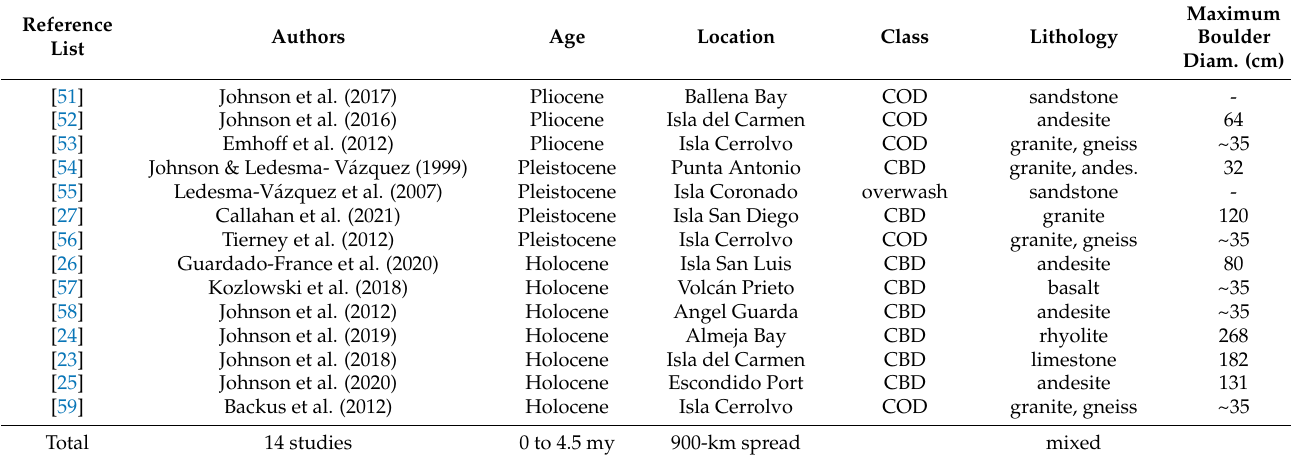
Table 2. Pliocene to Holocene coastal boulder deposits (CBDs) and coastal outwash deposits (CODs) among islands and shores of Mexico’s Gulf of California on the Baja California peninsula. Listing is north to south in each age